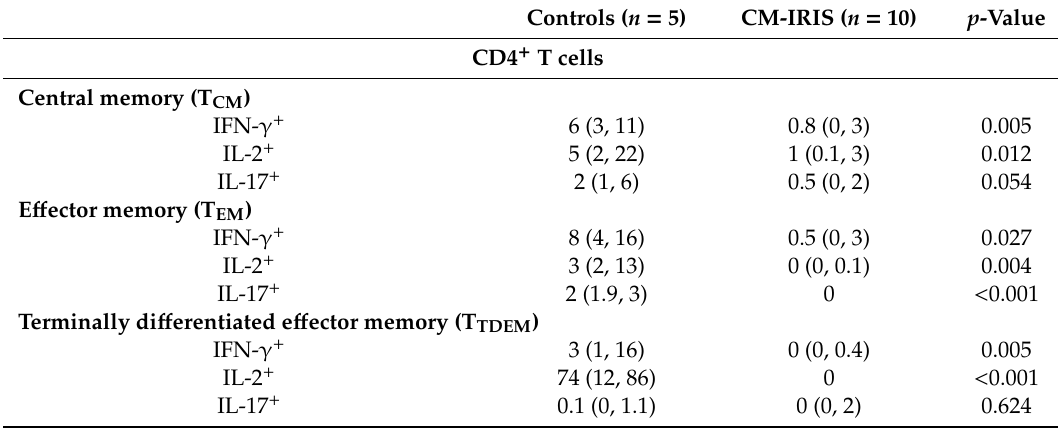
Table 2. Cytokine responses by T cell phenotype among subjects with CM-IRIS vs. controls following GXM stimulation at CM diagnosis.